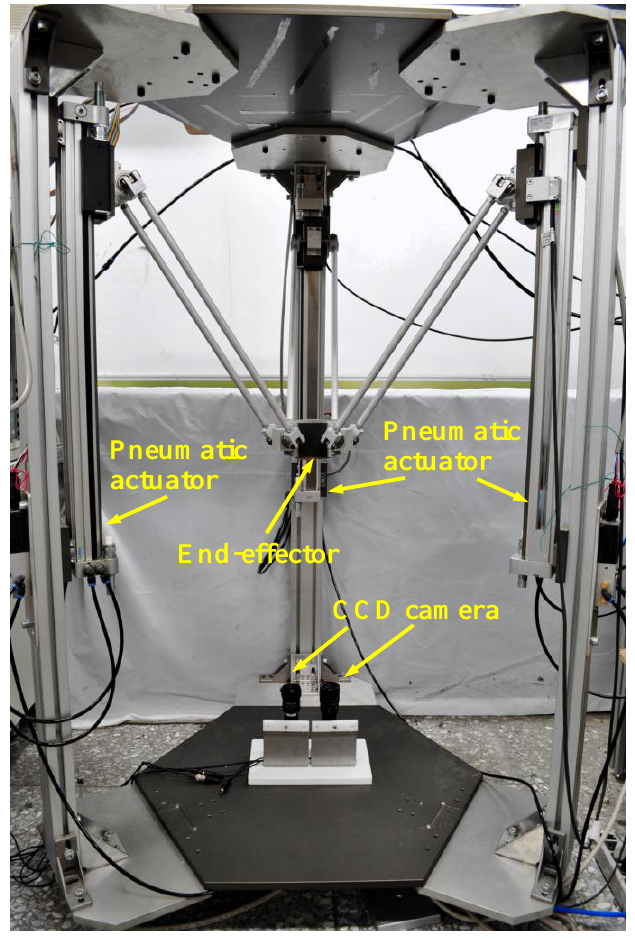
Figure 3. The layout of the test rig.